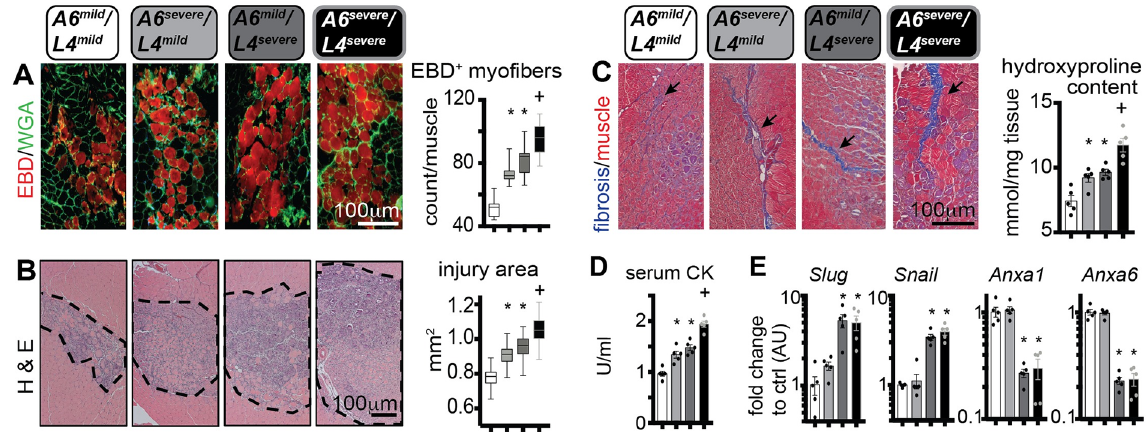
Fig 9. Relative contribution of Anxa6 and Ltbp4 alleles on muscle injury in vivo. A) Three days post-injury, the numberof dye + myofibers(red) in injured tibialis anterior muscles was increasedin single homozygous mice, either A6 severe or L4 severe , comparedto doublehomozygous A6 mild /L4 mild muscle, which displayedthe fewest dye+ fibers. Doublyhomozygousanimals A6 severe /L4 severe had the greatest numberof dye + fibers. B) The same pattern was seen when measuringinjury area from cardiotoxin injected gastrocnemius muscles measured 7 days post-injury. C) Scarring monitored by Masson’s trichrome staining (left panels;arrows) and hydroxyproline content (right chart) was also greatest in doubly mutant (A6 severe /L4 severe ) gastrocnemius muscles 7 days post-injury. D) 24 hours after cardiotoxin-injuryof hindlimbmuscles, serum CK levels were increasedin single homozygous mice A6 severe or L4 severe , and further increasedin doublehomozygous A6 severe /L4 sever e animals. E) Seven days after cardiotoxininjury, Slug , Snail were upregulatedwhile Anxa1 , and Anxa6 expressionlevels were significantly downregulated in muscle in the presenceof homozygous L4 severe allele( tibialisanterior )indicating that the L4 severe alleleimpacts Anxa1/Anxa6 expression likely via Slug/Snail regulation. * , P < 0.05vs A6 mild /L4 mild , +, P < 0.05vs A6 severe /L4 mild and A6 mild /L4 severe groups, 1way ANOVA + Bonferroni.